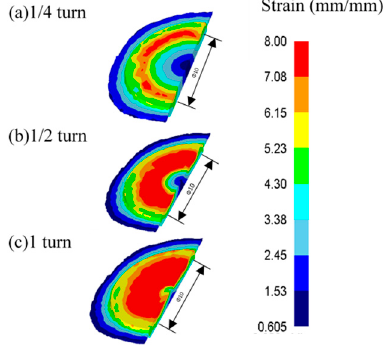
Figure 2. Distribution of strain on the half-disc surfaces and along the disc longitudinal sections for samples with ( a ) 1/4 turn; ( b ) 1/2 turn; and ( c ) 1 turn.